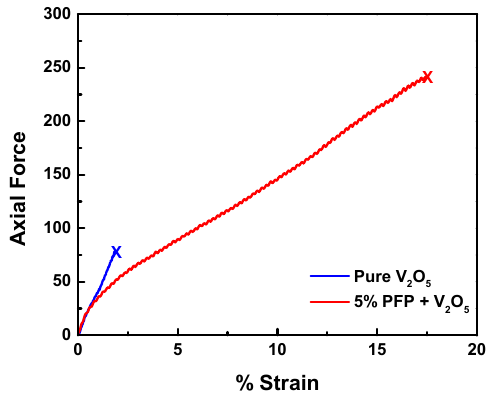
Figure 5. Dynamic mechanical analysis (DMA) failure tests for pure V 2 O 5 and V 2 O 5 with 5% PFP added.